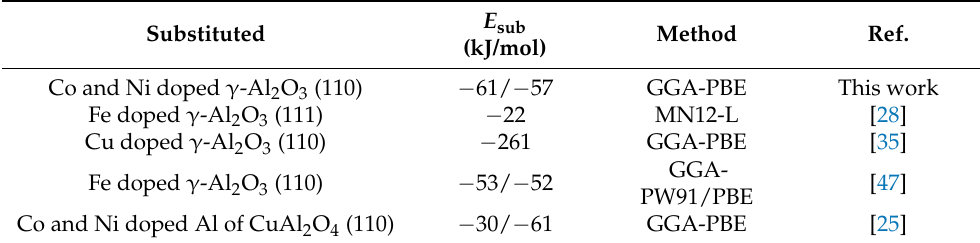
Table 2. The E sub and calculation method of different metals substituted